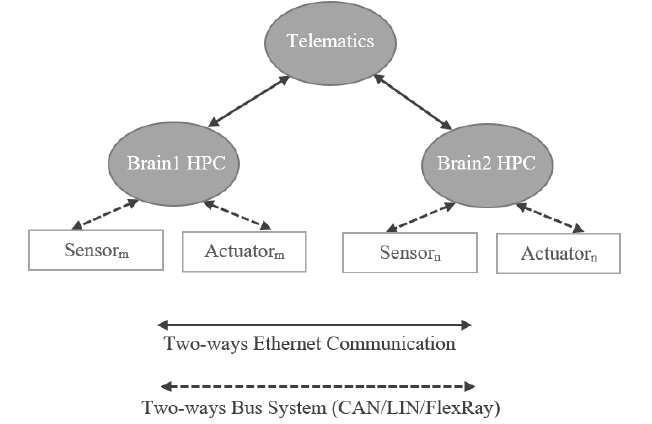
Figure 13. Representation of Two-Brain E/E